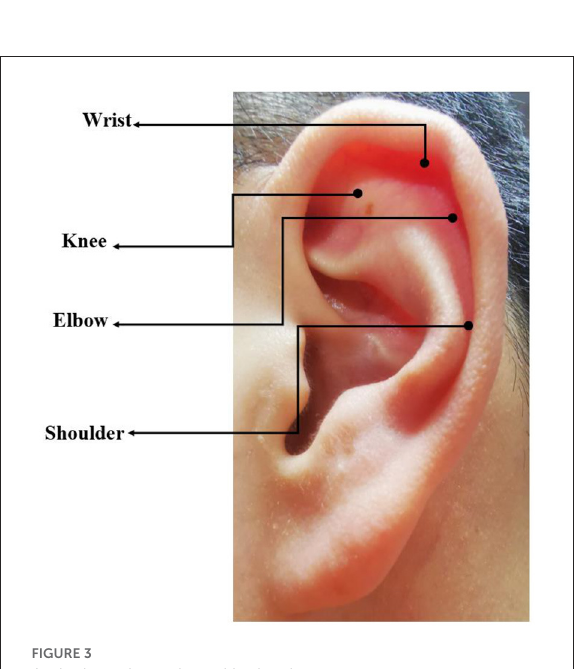
FIGURE3 Auricular points selected in the sham